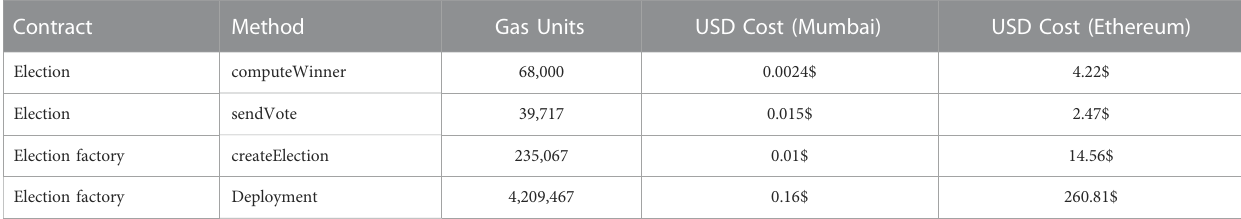
TABLE 1 Average costs of execution in the Mumbai and Ethereum network. Average price per gas unit of 43 gwei.